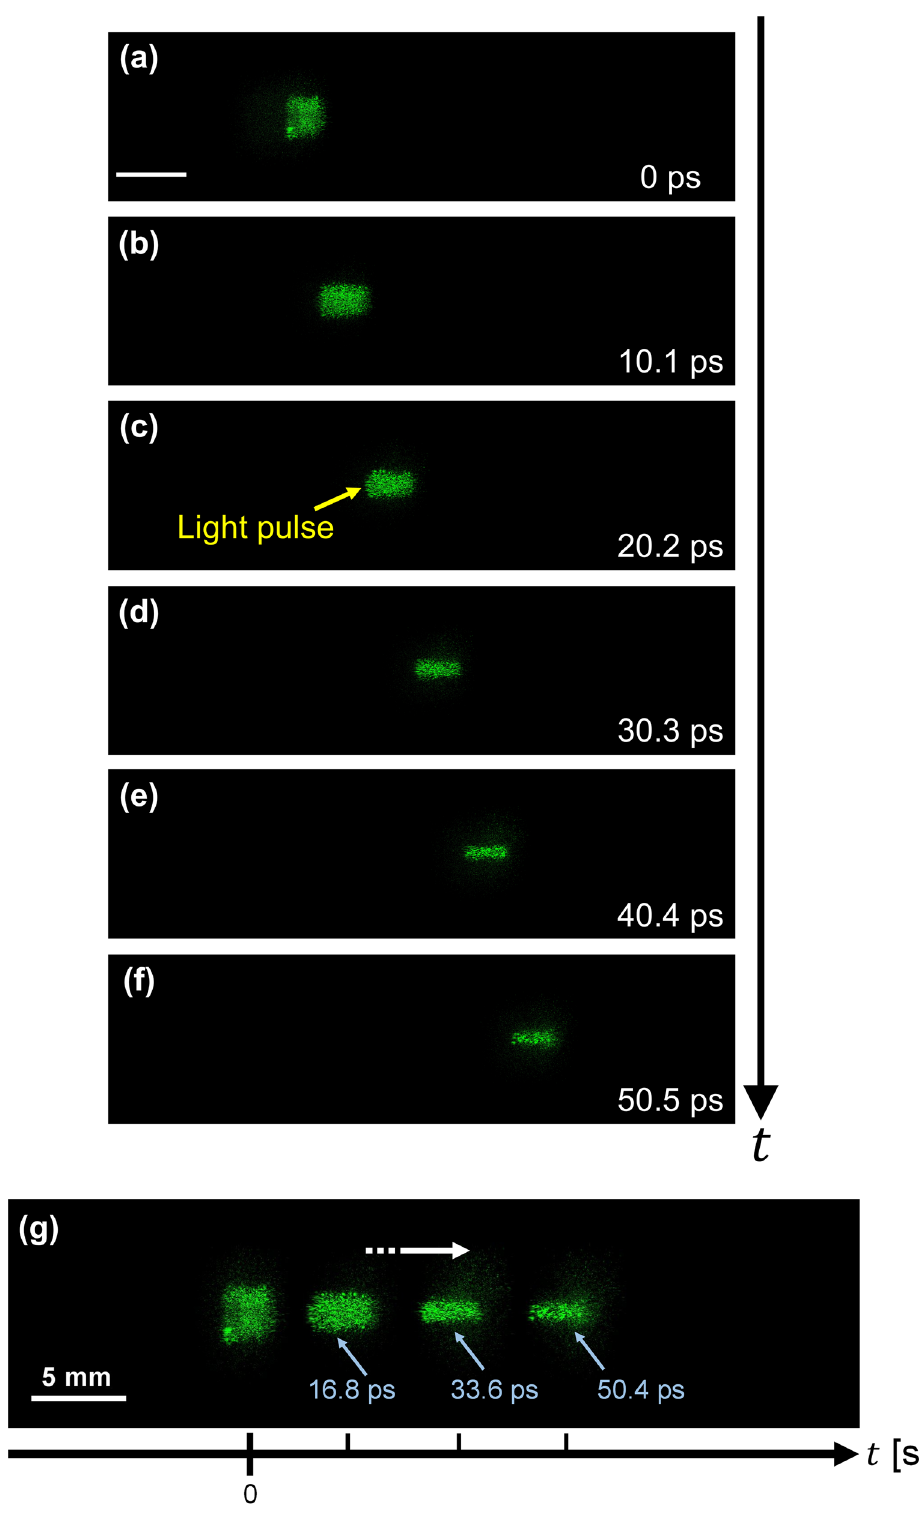
Figure 3. Frames extracted from the motion picture of the reconstructed images of a converging light pulse. ( a – f ), Converging light pulse in the 3-D scattering medium. The light pulse was propagating from left to right (see Video S1). The time interval between each picture was 10.1 ps. The light pulse was just focused in ( e ) and diverging in ( f ). Scale bar: 5 mm. ( g ) Figure shows the temporal change of the light pulse propagation by combining some reconstructed images. The striped arrow indicates the direction of the light pulse